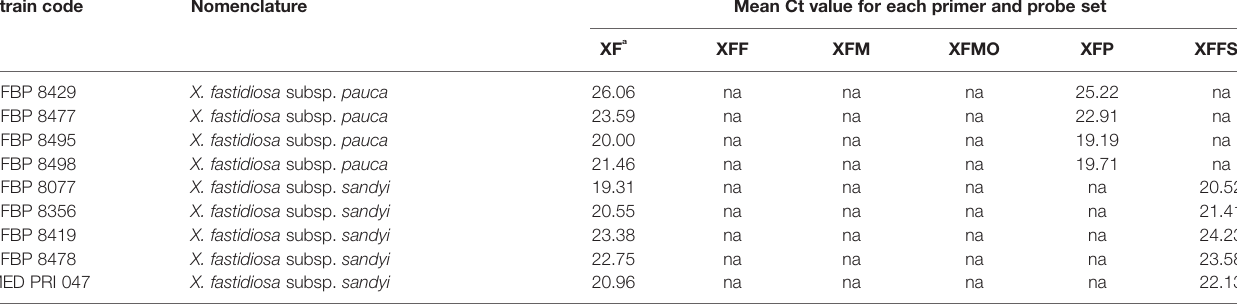
TABLE 2 | Description and composition of the longest speci fi c long-mers obtained using SkIf for the various targets. Target a Long-mer size Long-mer position (in the genome of the given strain) Targeted CDS: locus name, position (bp)